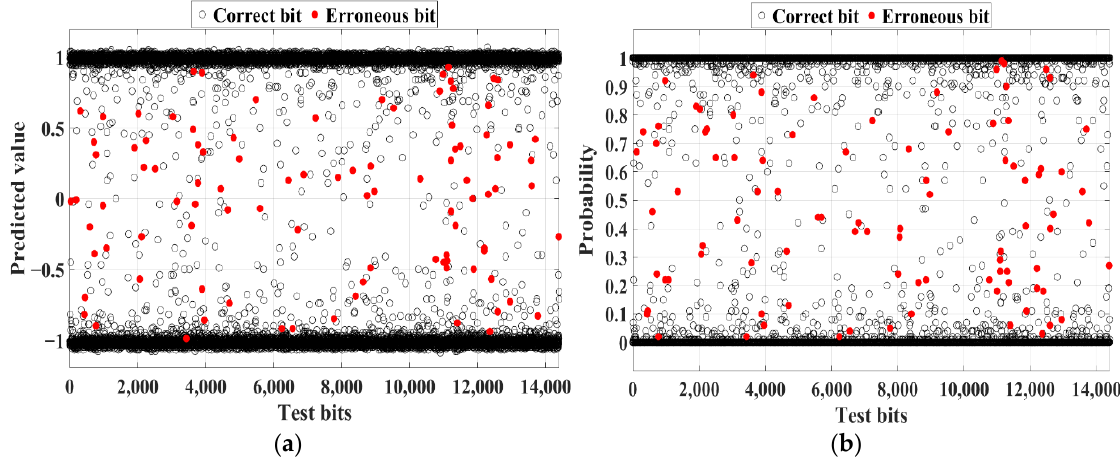
Figure 2. The prediction output value: ( a ) regression MLP; ( b ) classification MLP.